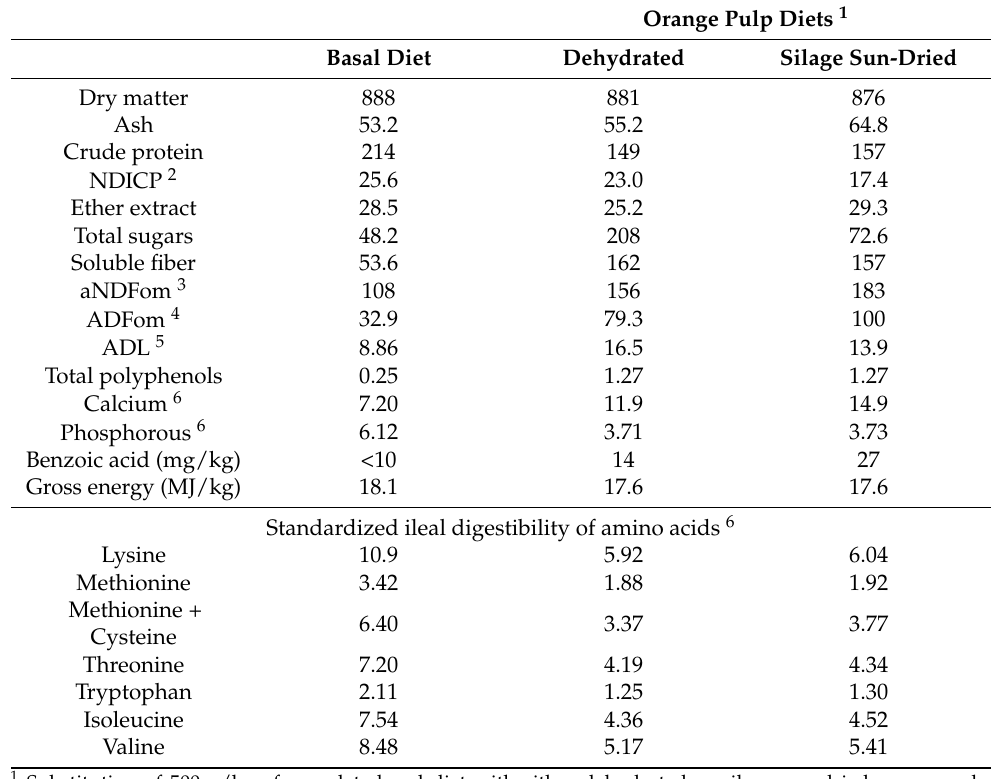
Table 3. Nutrient content of the diets (g/kg, dry matter